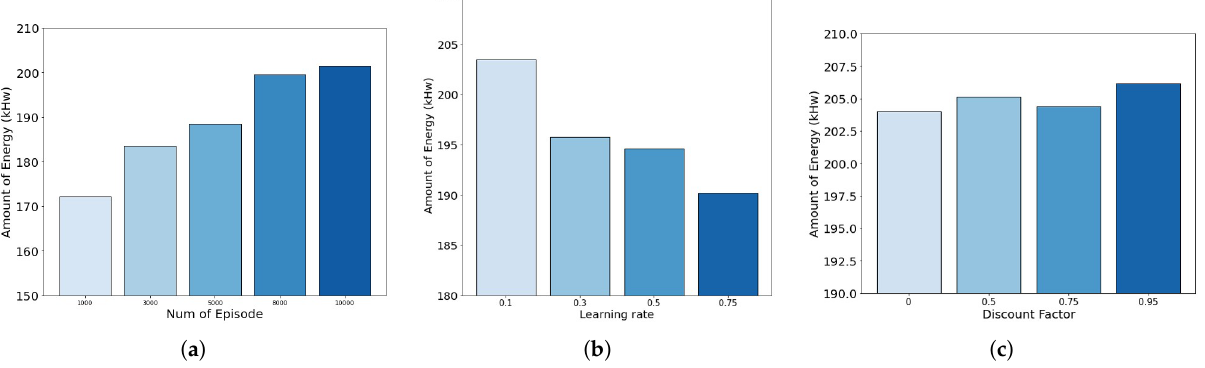
Figure 9. Adjusting parameters according to the amount of solar energy generated per day. ( a ) Ad- justing number of episode; ( b ) Adjusting learning rate; ( c ) Adjusting discount